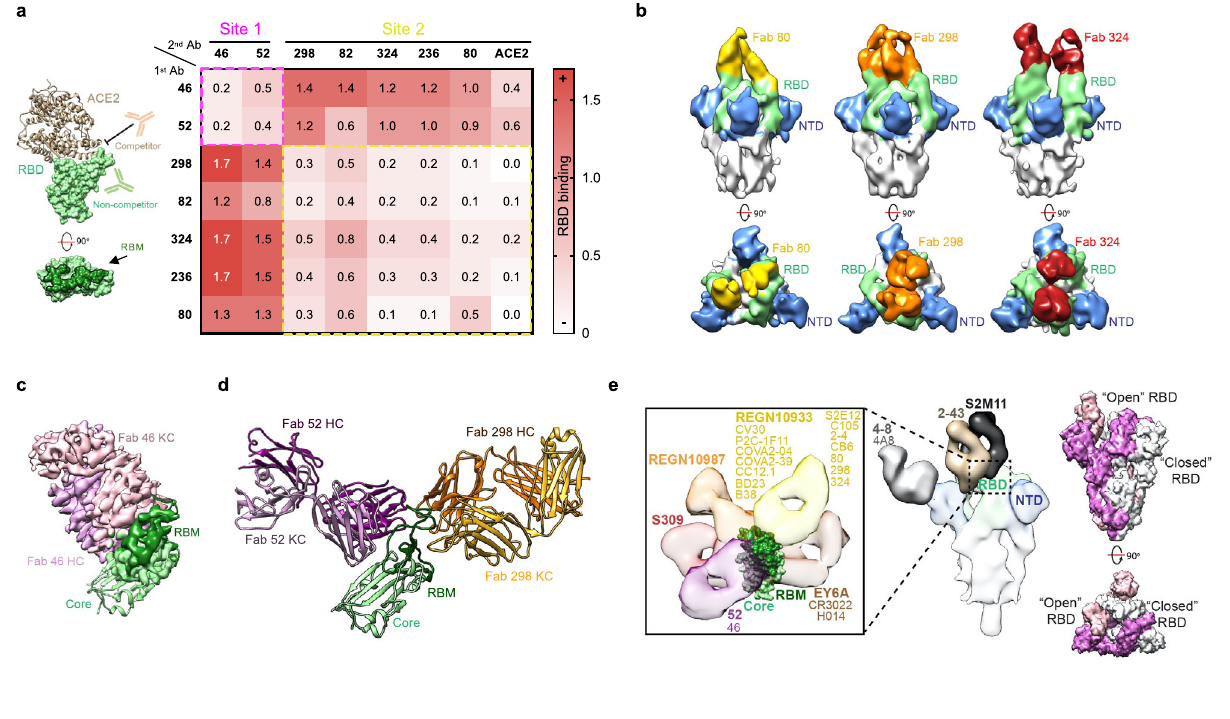
Fig. 5 Epitope delineation of the most potent mAb speci fi cities. a Surface and cartoon representation of RBD (light green for the core and dark green for RBM) and ACE2 66 (light brown) binding. Heat map showing binding competition experiments. High signal responses (red) represent low competition while low signal responses (white) correspond to high competition. Epitope bins are highlighted by dashed-line boxes. b 15.0 Å fi ltered cryo-EM reconstruction of the Spike (gray) in complex with Fab 80 (yellow), 298 (orange), and 324 (red). The RBD and NTD are shown in green and blue, respectively. c Cryo-EM reconstruction of the Fab 46 (pink) and RBD (green) complex. A RBD 66 secondary structure cartoon is fi tted into the partial density observed for the RBD. d Crystal structure of the ternary complex formed by Fab 52 (purple), Fab 298 (orange), and RBD (green). e Composite image depicting the side and top view of the unliganded (PDB 6XM4) and the antibody-bound SARS-CoV-2 spike with available PDB or EMD entries 3,4,9,10,13,15,17,67 – 72 . Inset: close up view of antibodies targeting different antigenic sites on the RBD. The mAb with the lowest reported IC 50 value against SARS-CoV-2 PsV was selected as a representative antibody of the bin (highlighted in bold) and those antibodies with similar binding epitopes are listed in the same color below (color coding of Spike, NTD and RBD as in ( b )). Individual protomers in the unliganded spike are shown in white, pink, and